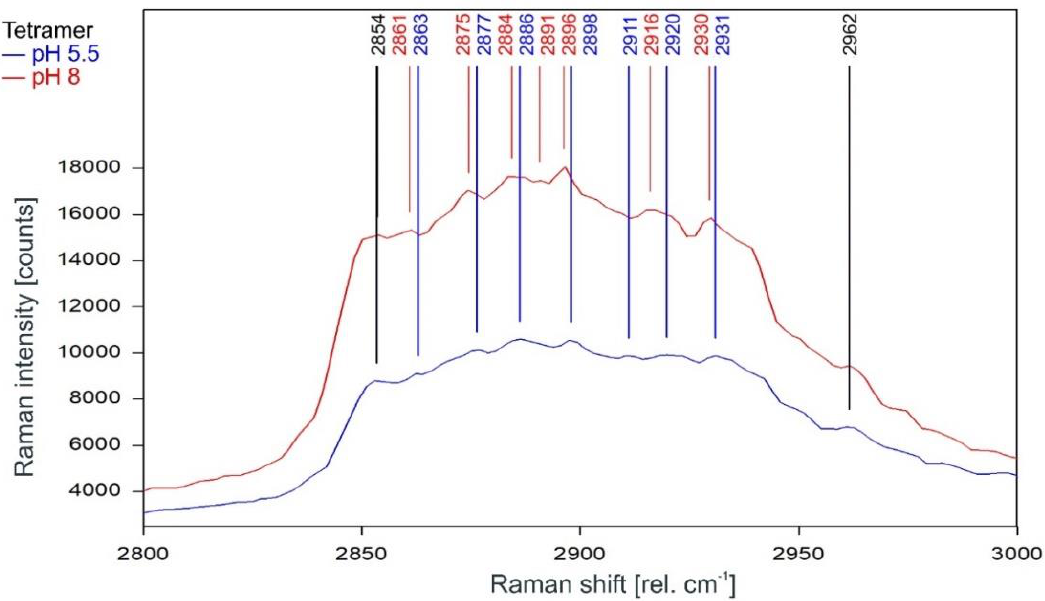
Figure 7. Raman spectrum of the KcsA channel between 2800 and 3000 rel. cm −1 in its open state at pH 5.5 (blue) and its closed state at pH 8 (red) as recorded. Raman lines shared by the spectra are marked in black.